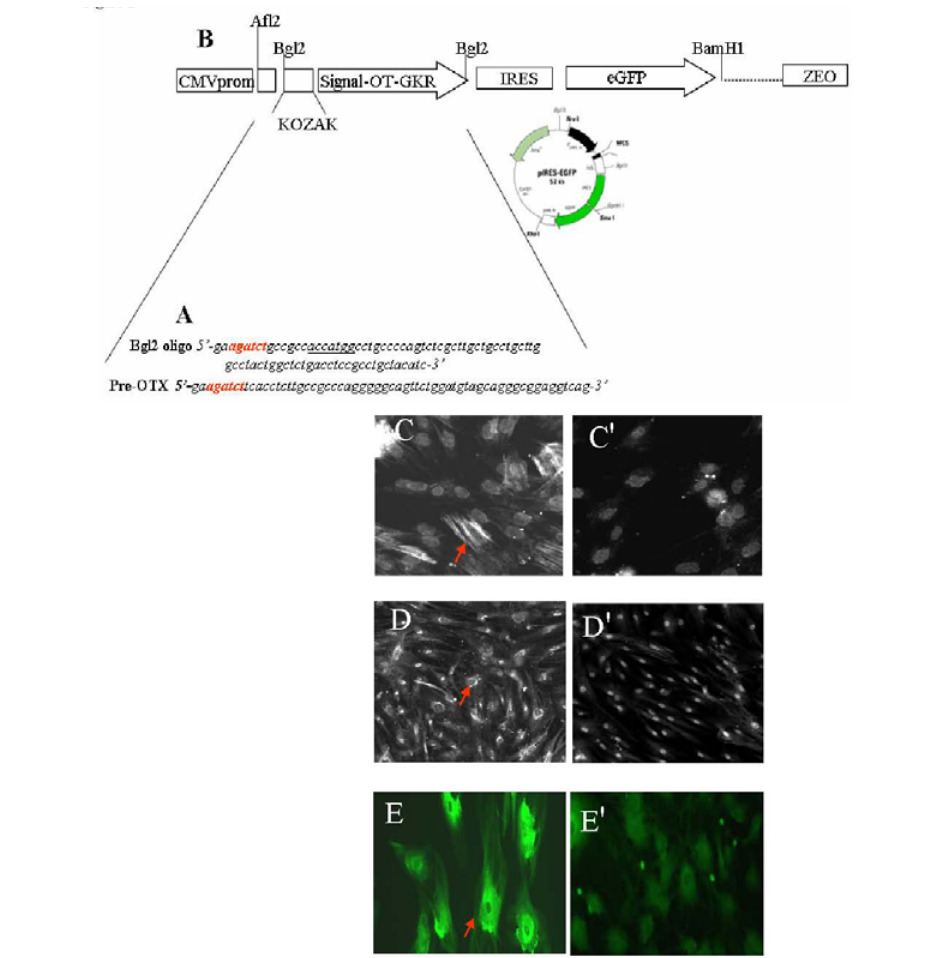
Figure 2. OT treatment of stem cells stimulates vascular cell markers. The sequence of oligonucleotides presented in ( A ) were used for: Construction of sites sensitive for restriction enzyme Bgl2 used for cloning (red); construction of consensus sequence for initiation of translation coding sequences (KOZAK, underlined) and, the generation of region coding OT-Gly-Lys-Arg (OT-GKR) oligopeptide. Oligonucleotide ligation, PCR amplification and molecular cloning in bacterial vector were performed in collaboration with Dr. Dominic Devost and Dr. Hans H. Zingg, McGill University. ( B ) The construct was introduced into internal ribosome entry site (IRES) vector containing the cytomegalovirus (CMV) promoter, the green fluorescence protein (eGFP) sequence and zeomycin resistance gene. This construct was employed for transfection of human mesenchymal cells. For transfection, 2 µg plasmid DNA was mixed with FuGENE 6 Transfection Reagent (Roche Diagnostics, Indianapolis, IN, USA: Cat. No. 11 815 091 001) according to the manufacturer’s specifications. Cells expressing OT-GKR protein produced smooth muscle actin ( C ) and vascular endothelial growth factor ( D ), as detected by immunofluorescence. Control mesenchymal cells transfected with the vector were negative ( C' and D' , respectively). Vascular endothelial growth factor production was also stimulated by OT treatment of stem cell fractions isolated from the rat heart as side population (E), compared to non-treated controls ( E'